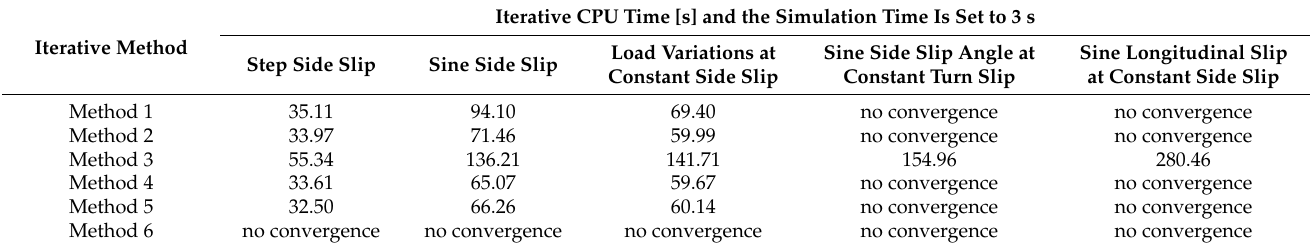
Table 1. The iterative CPU times of different methods at different